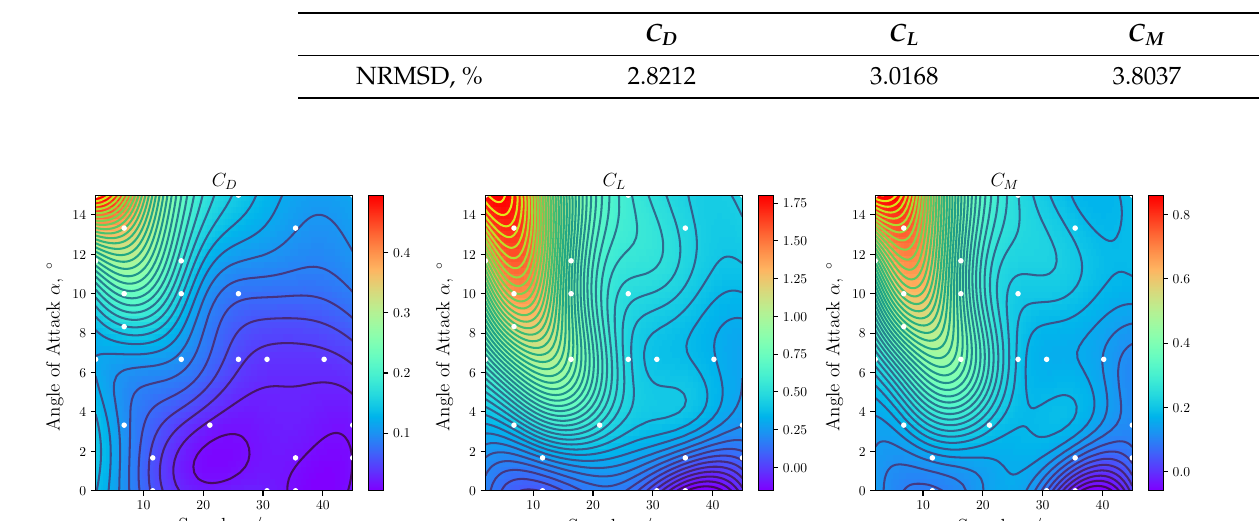
Figure 11. Surrogate contour plots for the coefficients of the Waid-Lindberg supercavitating hydrofoil. These profiles include the cavitation effects.